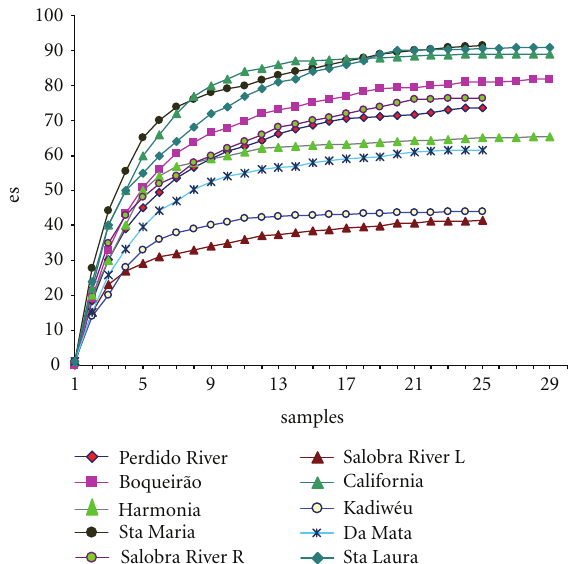
Figure 3: Comparison of incidence-based ant species rarefactions curves showing expected species richness (es) versus sampling e ff ort in ten sampling sites (samples) in the Bodoquena mountain range.